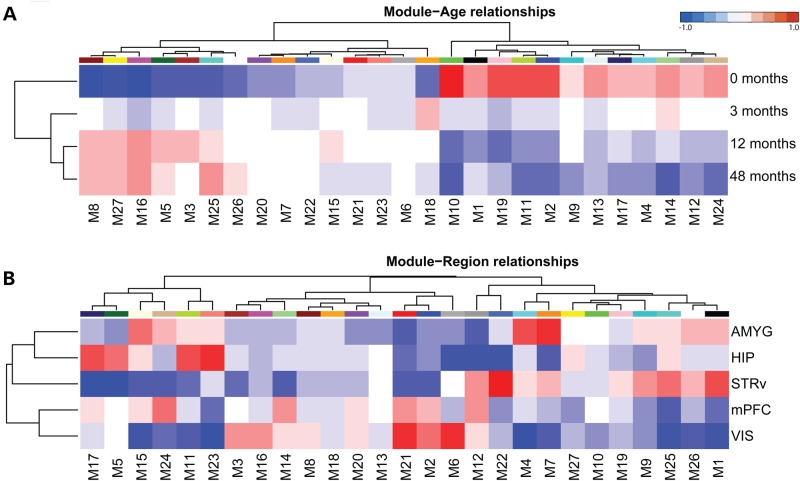
WGCNA identified modules predominately associated with region and age. Heatmap plot shows the correlation between MEs and age (A) or region (B). Modules were hierarchically clustered and sorted along the x-axis based on their eigengene–trait relationships. Traits were likewise sorted along the y-axis. Red indicates positive correlation, while blue shows negative correlation.